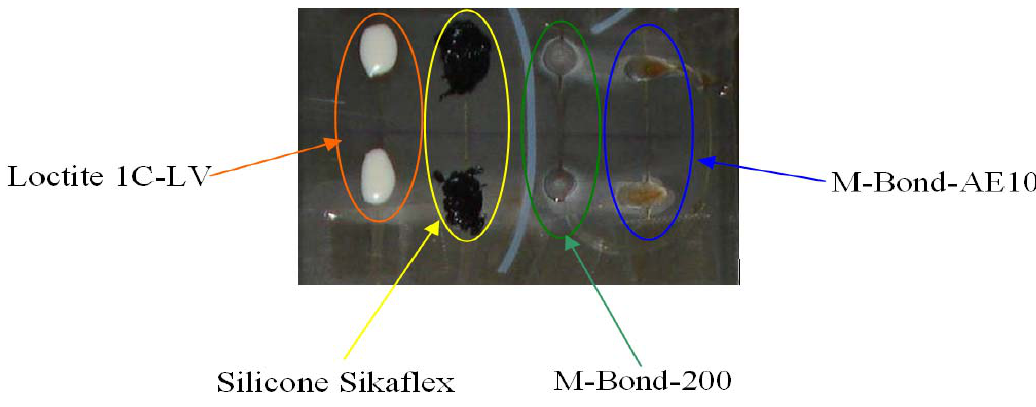
Figure 2. Four FBG sensors glued on Specimen 3 with four different adhesives.